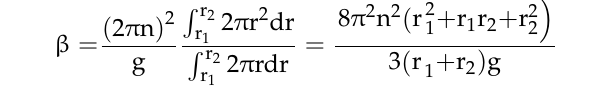
Figure 3. Droplet size and PDI at different emulsification temperatures.